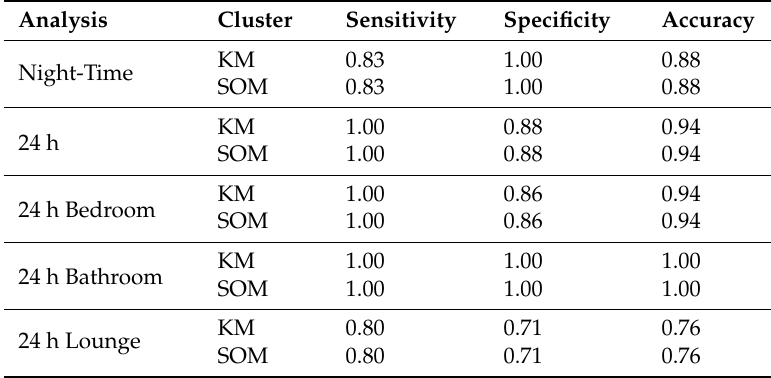
Table 3. Validation with carers. Comparison with clinical